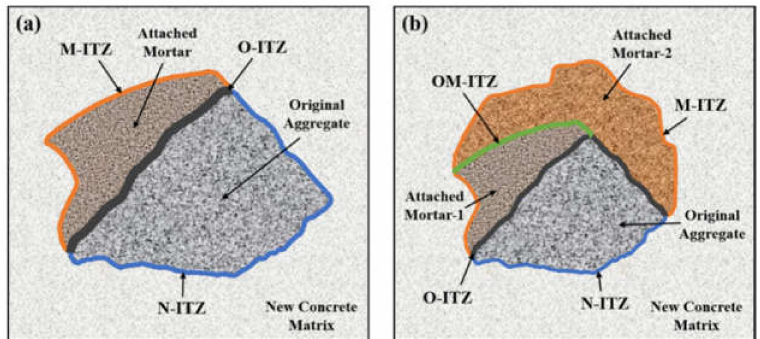
Figure 5. Schematic diagram of interfacial transition zones (ITZs) in ( a ) RAC-1 and ( b ) RAC-2.